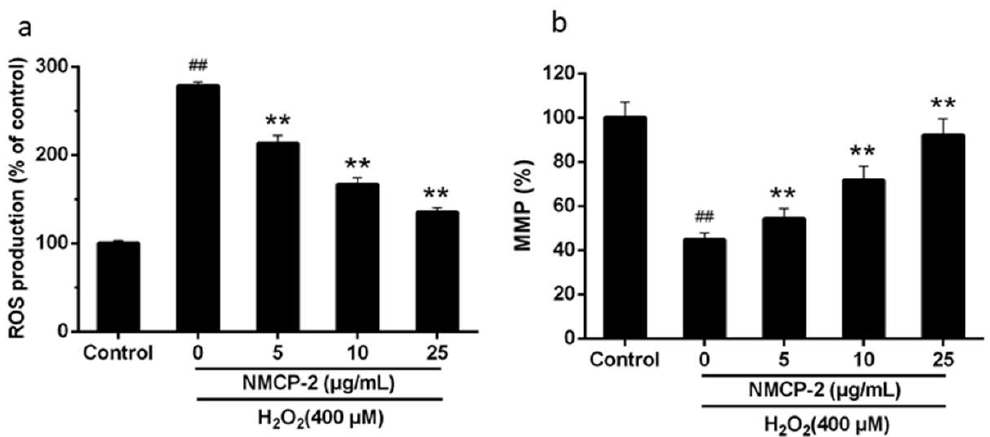
Figure 7. Effect of NMCP-2 on H 2 O 2 -induced intracellular accumulation of reactive oxygen species (ROS) and mitochondria membrane potential (MMP). Histogram showing the ( a ) ROS level and ( b ) MMP level in HEK 293T cells after treatment with H 2 O 2 in presence or absence of NMCP-2 (5, 25 µg/mL) compared to untreated groups. Data are presented as mean ± SD ( n = 3). ## p < 0.01 differs from control group; ** p < 0.01 differs from model group.